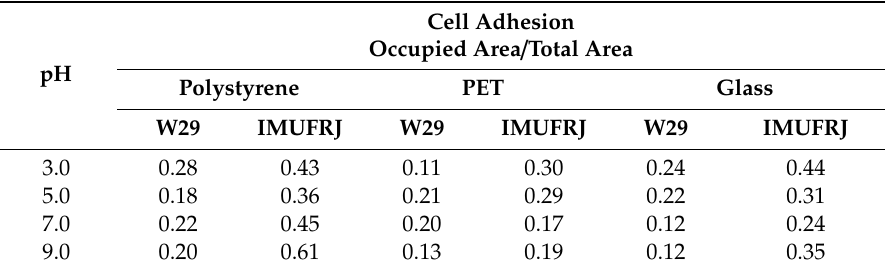
Table 3. Comparison of the adhesion of Y. lipolytica W29 and Y. lipolytica IMUFRJ to polystyrene, PET, and glass at ionic strength of 10 − 1 M and pH 3, pH 5, pH 7, and pH 9. Cell